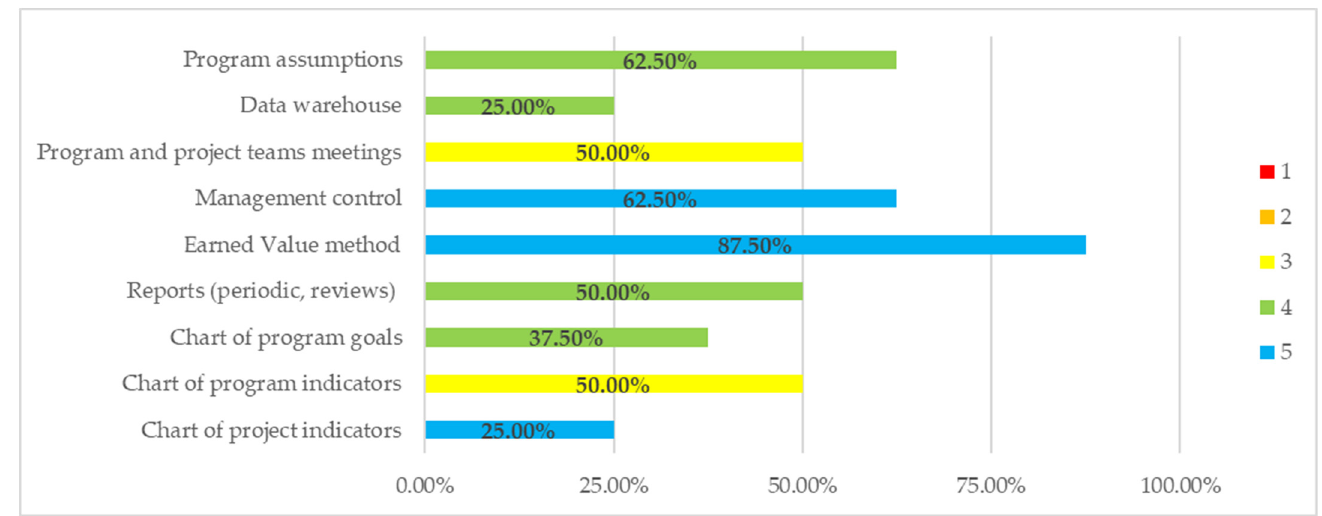
Figure 8. Evaluation of the effectiveness of the methods, techniques and tools used for the work monitoring and control process. Source: own elab.